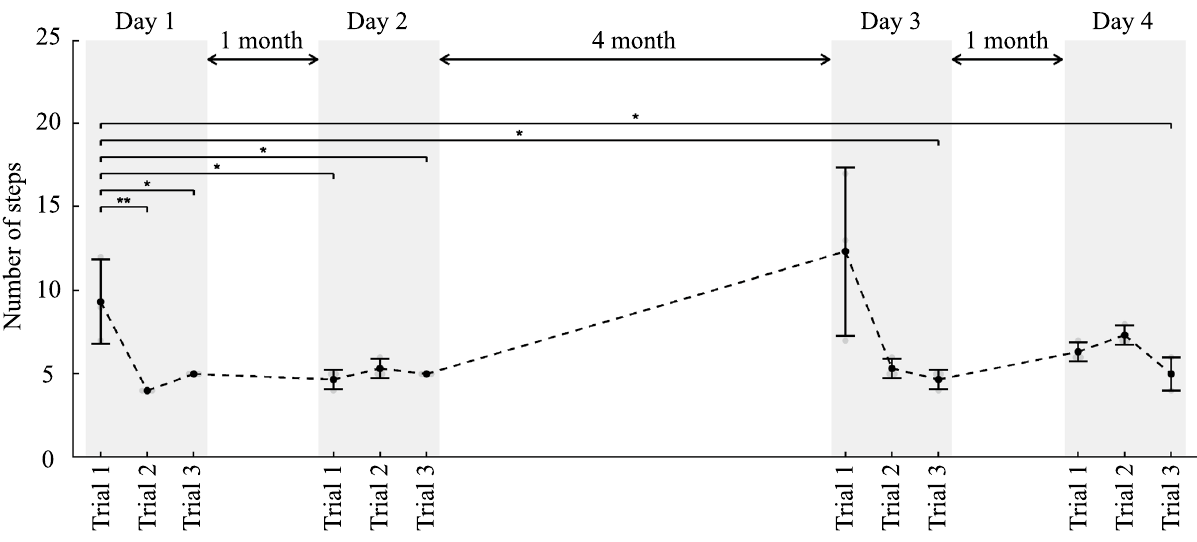
Figure 4. Experimental results of continuous intervention for Case 2 (progressive supranuclear palsy–pure akinesia with gait freezing). The black dots indicate the average number of steps in the turning area, and the error bars indicate the standard deviation of the value. **P < 0.01, *P < 0.05; absence of an asterisk indicates P > 0.05. Each trial consisted of preintervention without HAL (Trial 1), intervention with HAL (Trial 2), and postintervention without HAL (Trial